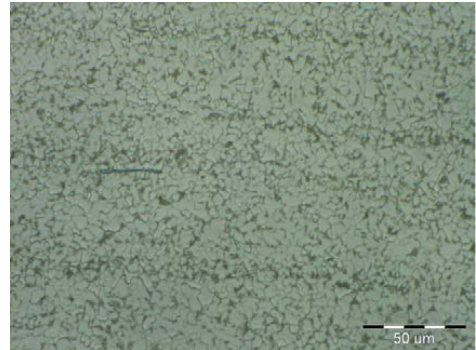
Figure 7. Magnified view of microstructure of base material.